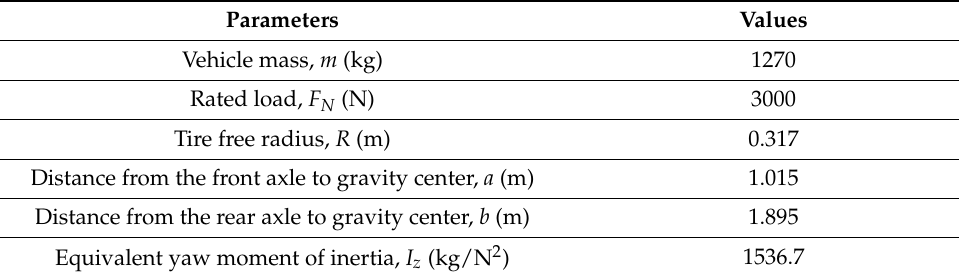
Table 2. Vehicle status